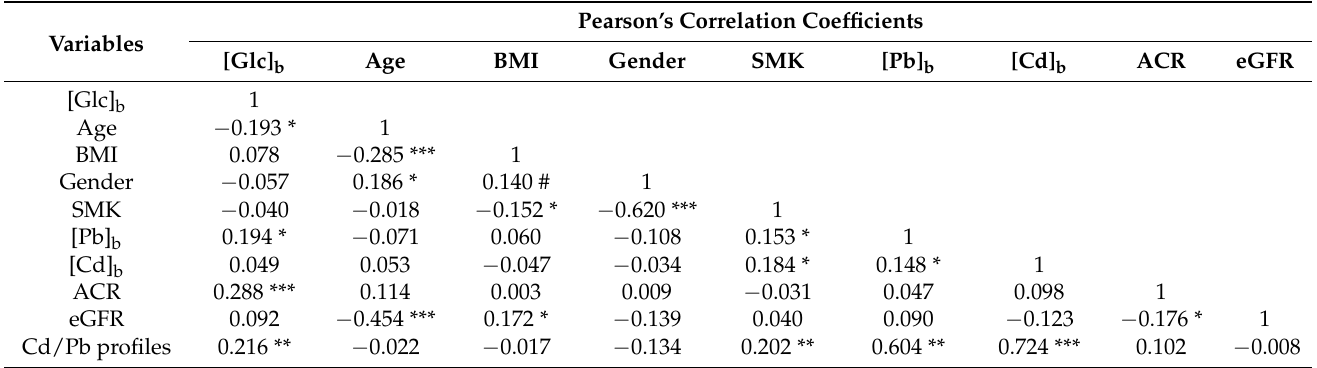
Table 4. Bivariate correlation analysis of fasting plasma glucose